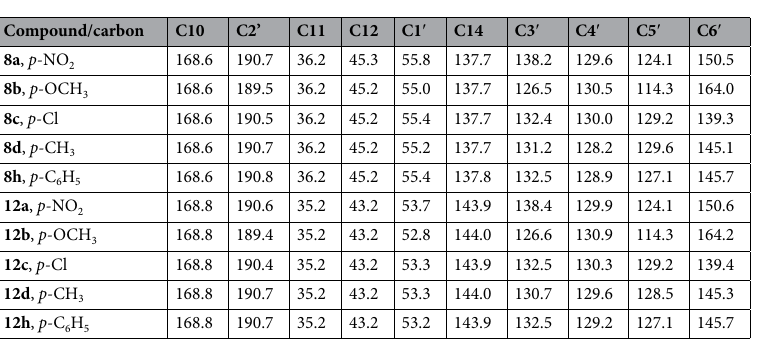
Table 2. The main 13 C-NMR spectral data for the most biologically active hybrids quinoline–imidazole/ benzimidazole compounds 8 and 12